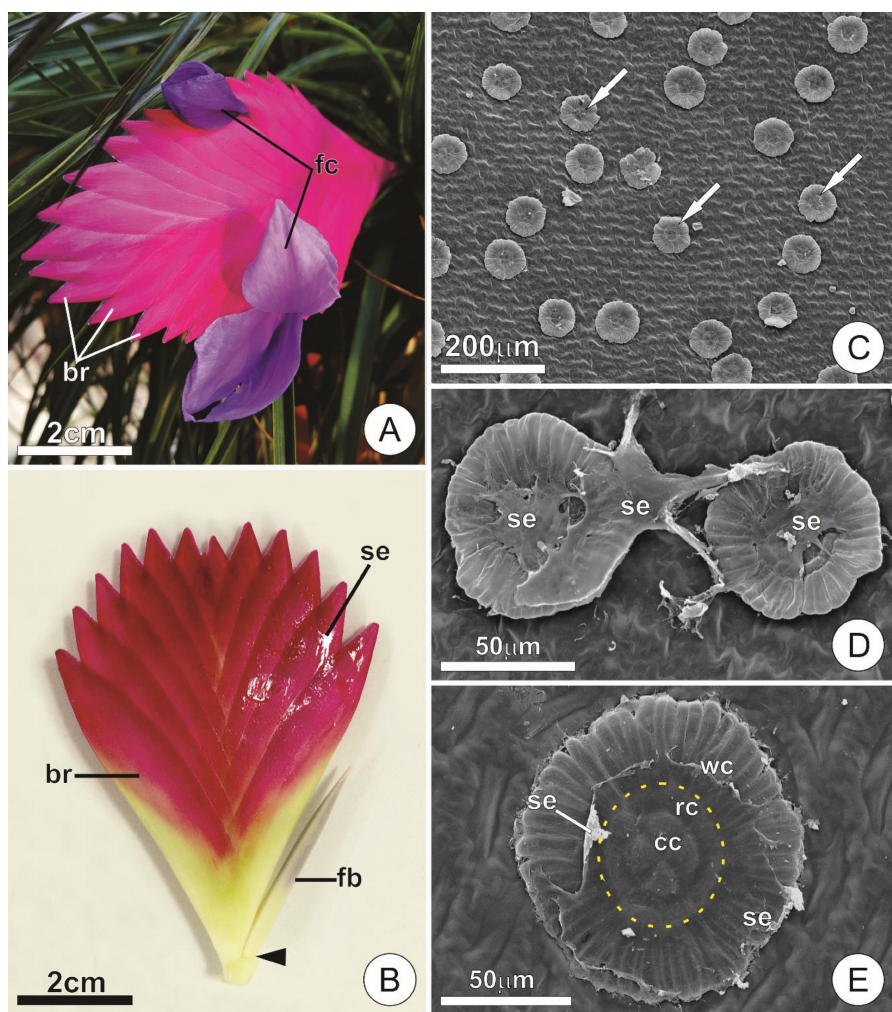
Figure 1. Distribution and aspect of secretory trichomes. ( A , B ) Overview of inflorescences at the flowering stage. Note the compact arrangement of bracts subtending the flowers with exposed corolla at anthesis ( A ) and the developing flower buds ( B ). The arrowhead indicates the removal of a bract. ( C ) Adaxial surface of a young bract showing numerous trichomes (arrows). ( D , E ) Detail of the secretory trichomes at di ff erent stages of expansion. Note the structure of the shield and a film of secretion covering its surface. The dotted area (in yellow) delimits the central disc. (br = bract; cc = central cells; fb = floral bud; fc = flower corolla; rc = ring cell; se = secretion; wc = wing